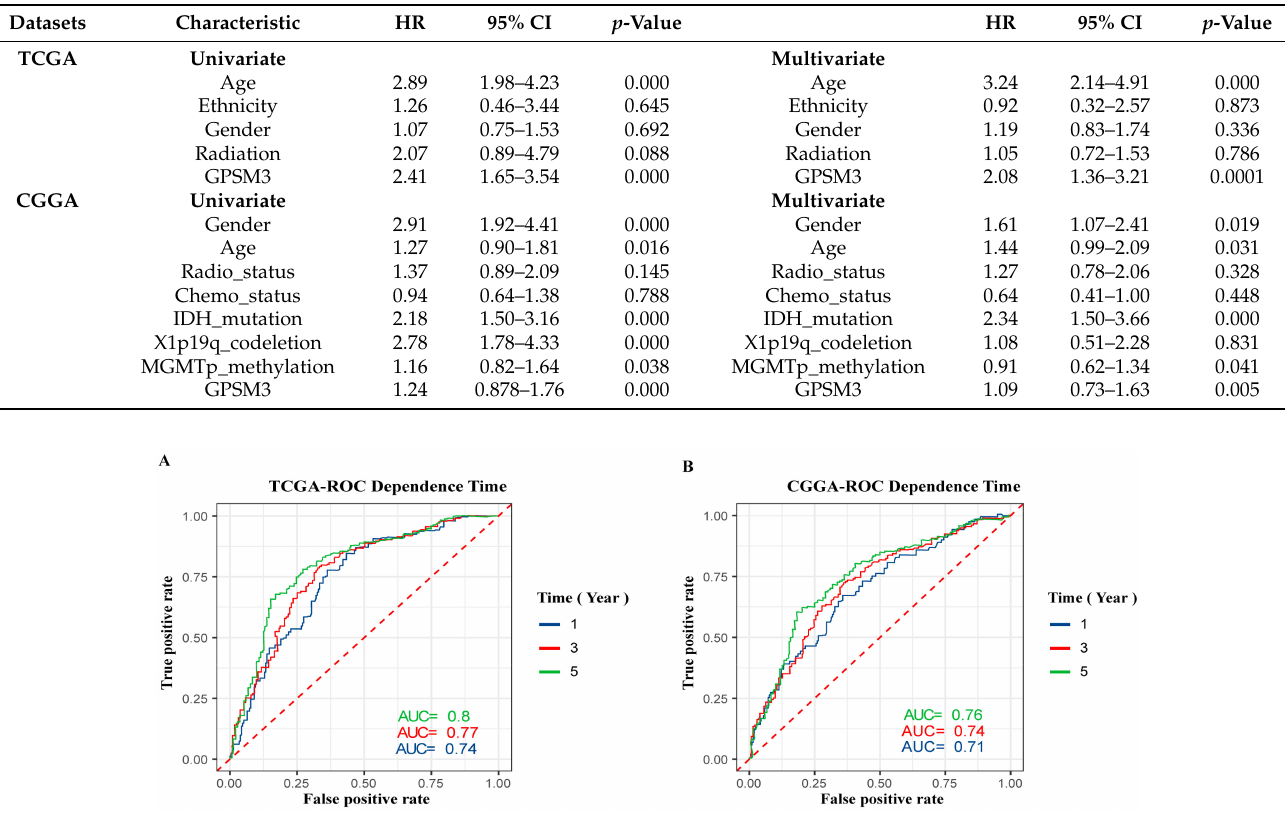
Figure 2. ROC curve analysis of GPSM3 in LGG patients. ( A ) ROC curve analysis of GPSM3 in LGG patients in the TCGA dataset. ( B ) ROC curve analysis of GPSM3 in LGG patients in the CGGA dataset. p -value < 0.05 was considered statistically